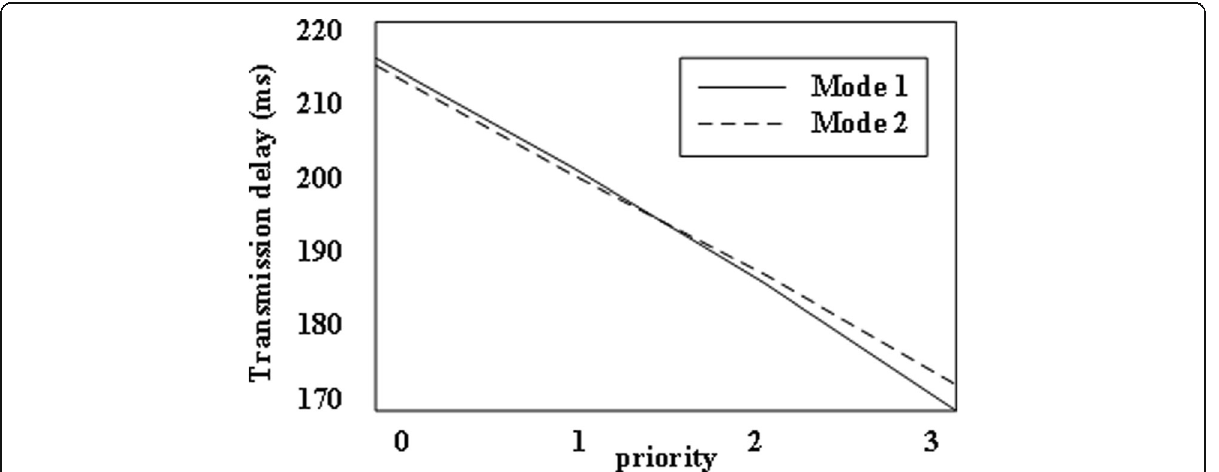
Fig. 5 Data packet transmission delay contrast